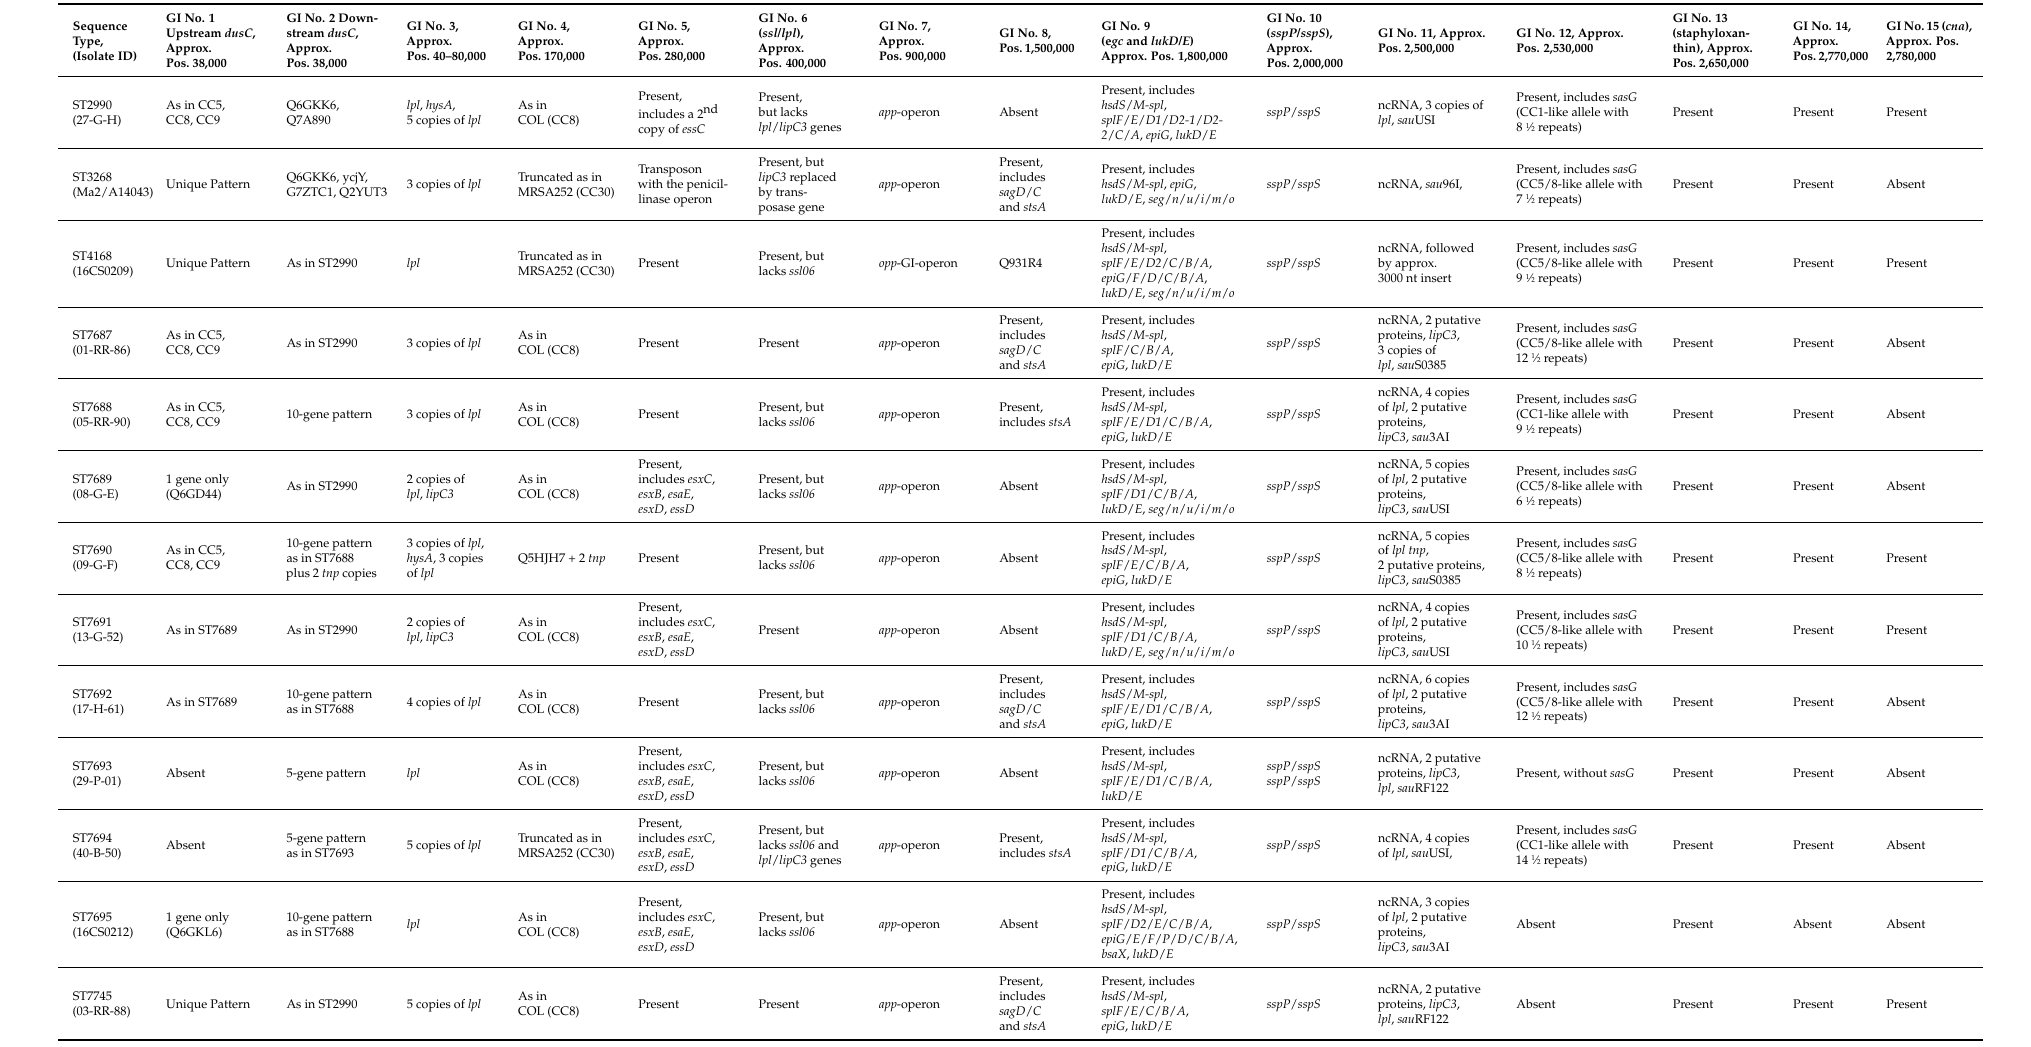
Table 2. Major genomic islands in study strains (please note that this is an abridged table; the full set is provided in Supplemental File S4). GINo. 1 Sequence Upstream dusC , Type, (IsolateID)